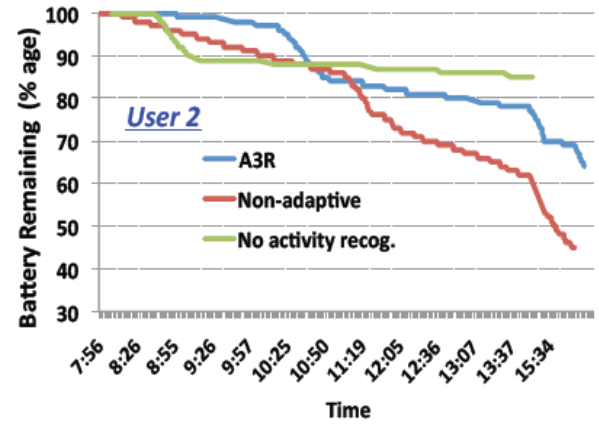
Figure 2. Accuracy at different sampling frequencies and classification features [6].